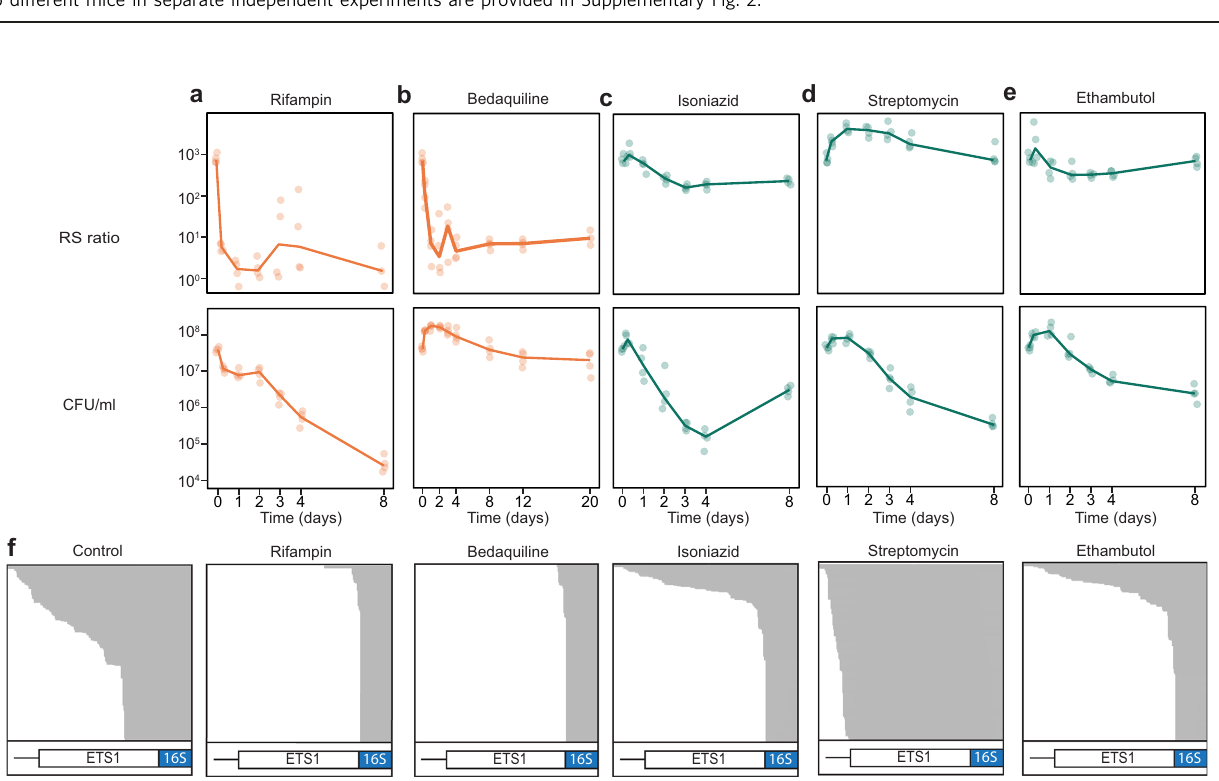
Fig. 3 Canonical sterilizing drugs suppress rRNA synthesis more than non-sterilizing drugs in vitro. Change in RS ratio and CFU burden in time-kill experiments with a rifampin, b bedaquiline, c isoniazid, d streptomycin, and e ethambutol. Sterilizing and non-sterilizing drugs shown in orange and green, respectively. Dots represent values from three independent experiments. Lines connect mean values from each timepoint. f RNAseq results for log-phase untreated control and after 48 h of drug exposure. Integrative Genomics Viewer (IGV) images demonstrate abundant ETS1 reads in the control sample compared with near-absence of ETS1 reads after exposure to rifampin and bedaquiline. Gray shading denotes individual reads. White and blue bars